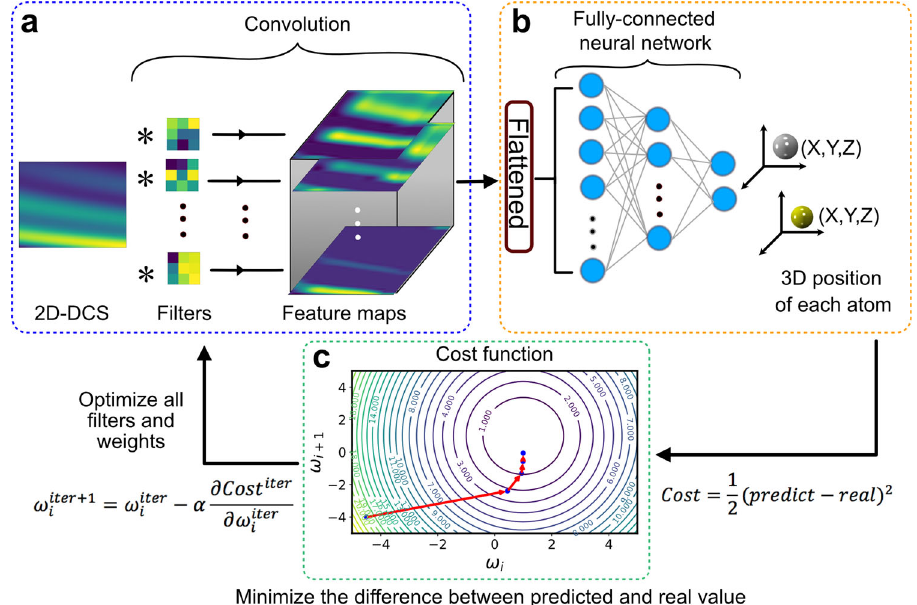
Fig. 2 CNN training of ML algorithm to predict molecular structure. a The 2D-DCS is convoluted by different fi lters to generate a collection of feature maps. b The collection of feature maps is fi rst fl attened into a one-dimensional array and multiplied by the weights in each neuron of all layers to predict the atomic position for each atom in the molecule. c Contour plot of the cost function for two weights ( ω i and ω i + 1 ). The blue dot represents the cost function value, and the red arrows show the direction of the gradient of the cost function. After fi ve iterations, the cost function is minimized.